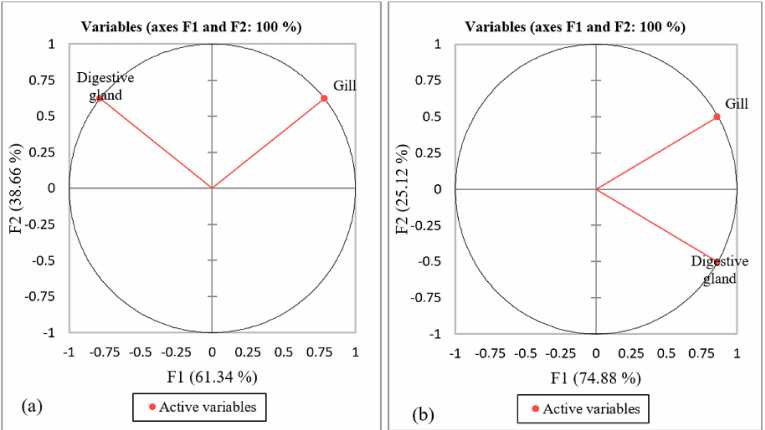
Figure 5. The PCA analysis results of the digestive gland and gill tissues of ( a ) glutathione and ( b ) AOPP. Similar results were reported for other aquatic animals such as mussels [71,72] and crayfish [73] exposed to xenobiotics. The effects of different pollutants on tissues require further investigation of their interactions on